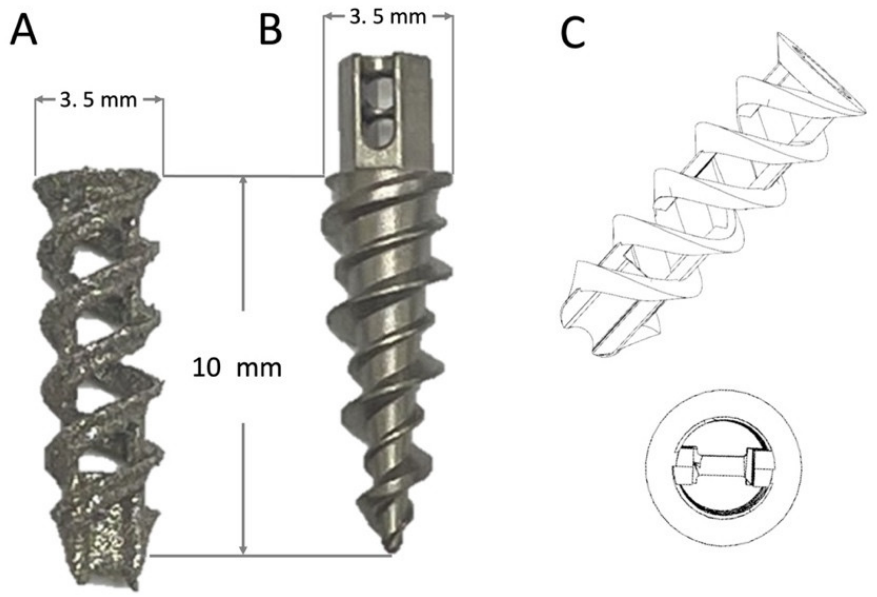
Figure 1. Specifications of the ( A ) open-construct double-helical Fe suture anchor (SA) and ( B ) screw-type Ti SA. ( C ) Illustration of the open-construct double-helical Fe SA.